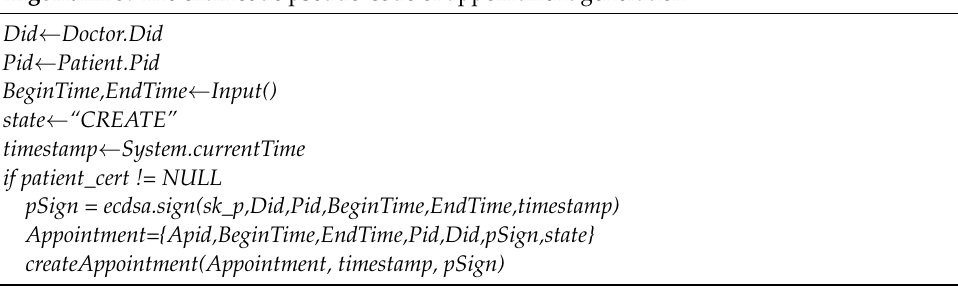
Algorithm 3. The chaincode pseudo-code of appointment generation.